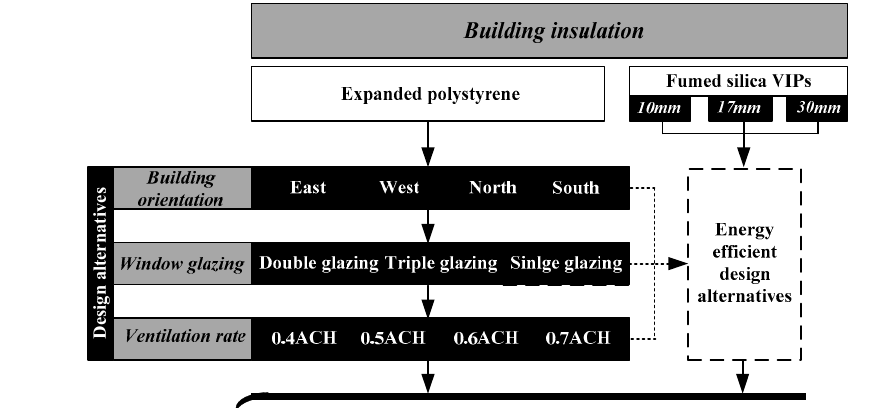
Figure 1. Four units in the middle floor.